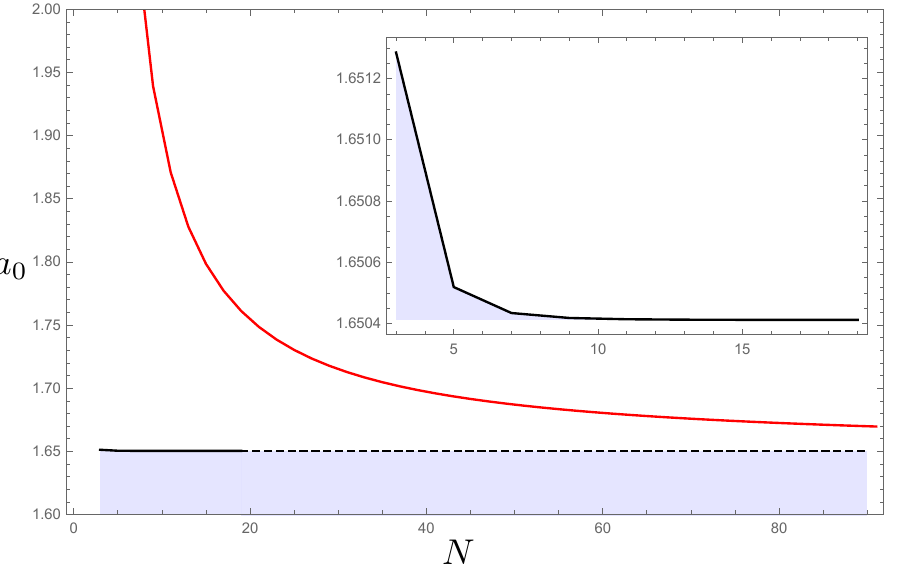
Figure 7 . Bound on a for (cid:1) = 2(cid:1) (cid:30) + 1 = 2 : 5 as a function of the number of components. In black 0 0 2 the bound obtained using functionals, in red the one with derivatives. The dashed line corresponds to a prolongation of the N = 19 functional result. The inset allows us to better see how fast the functional basis result converges. In particular these results show that in this case the bound using the functional basis with N = 3 signi(cid:12)cantly outperforms the derivative basis with N =